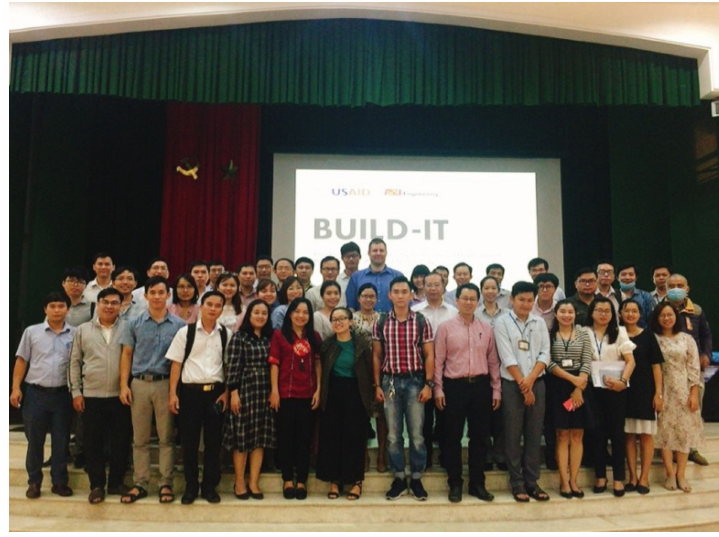
Figure 25. Training tutors in the scope of